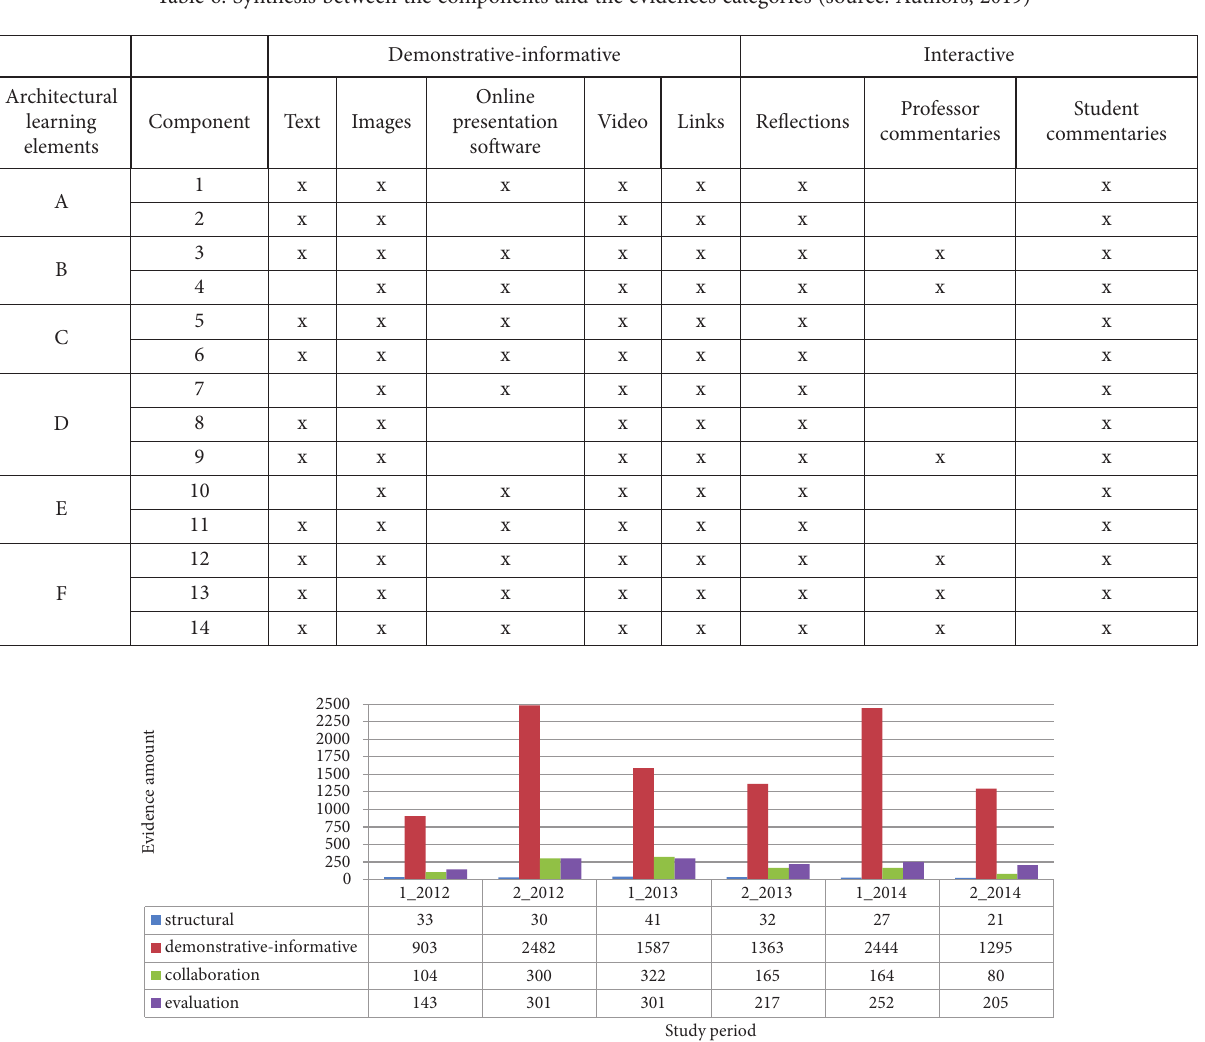
Figure 2. Evidence reflected in the e-portfolios (source: Authors,